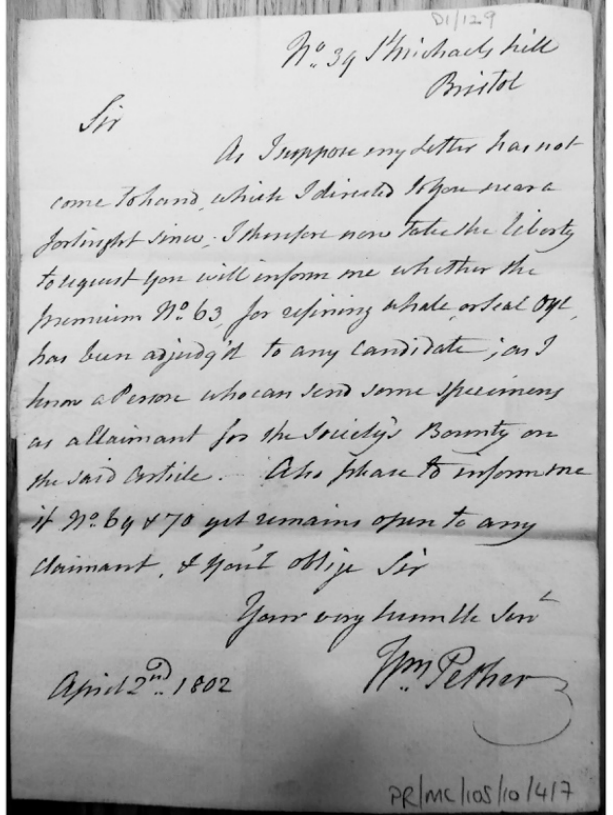
Figure 6. William Pether, Letter from William Pether about refining whale oil , 2 April 1802. Royal Society of Arts, Manufactures and Commerce Archives, London. Credit line: Royal Society of Arts, Manufactures and Commerce Archives, London.